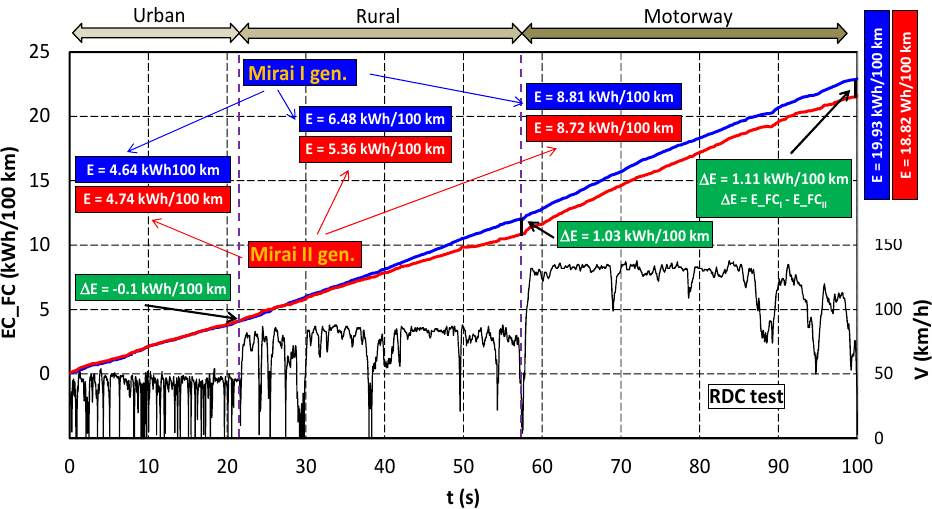
Figure 12. Changes in fuel cell energy consumption of the two generations of Toyota Mirai.